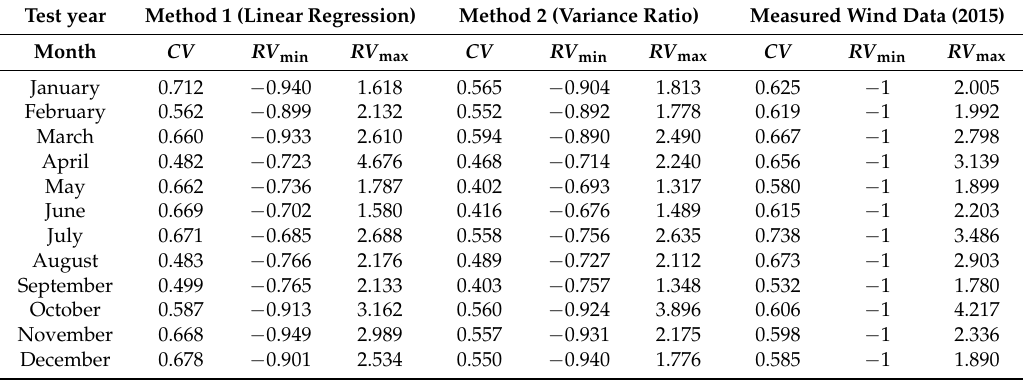
Table 3. Month-wise values of the coefficient of variation ( CV ) and range of variation ( RV ) for the